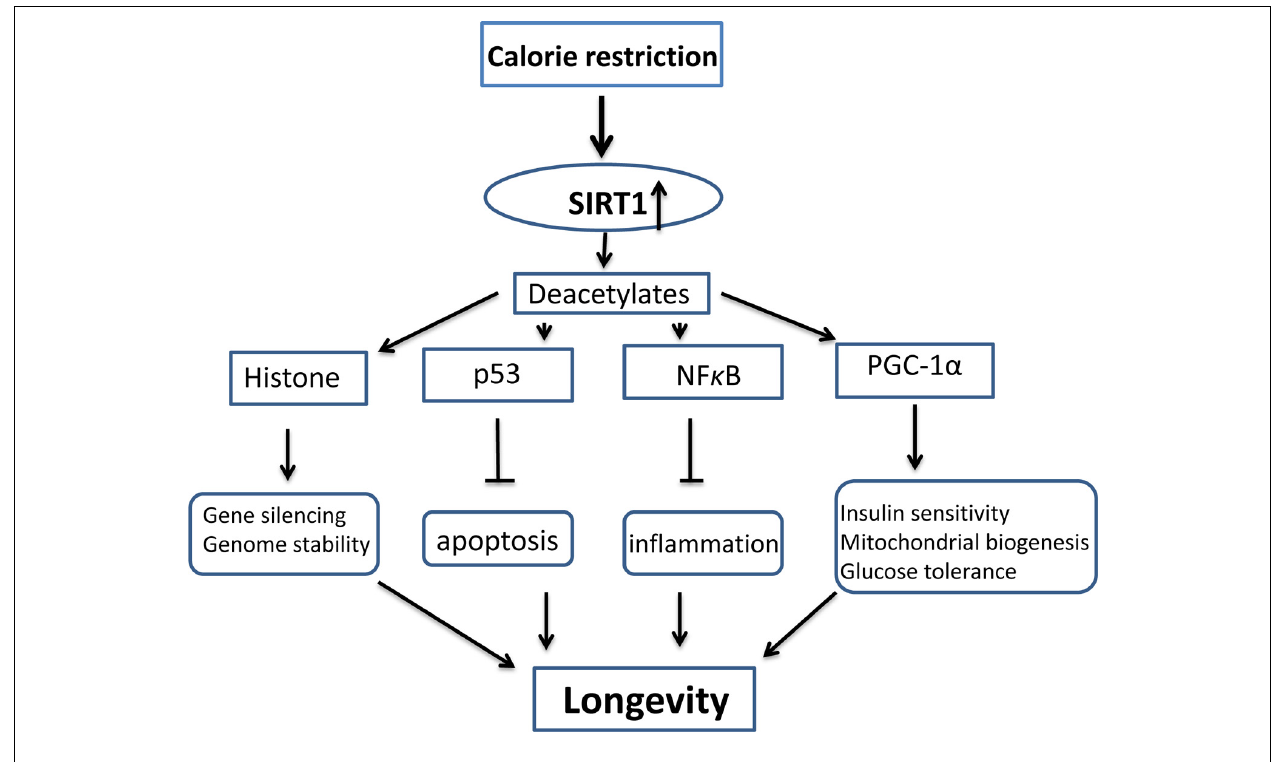
FIGURE 1 | Schematic diagram of anti-aging mechanism activated by SIRT1 and calorie restriction. Calorie restriction upregulates the activity and levels of SIRT1, SIRT1 deacetylates its substrates, including histone and